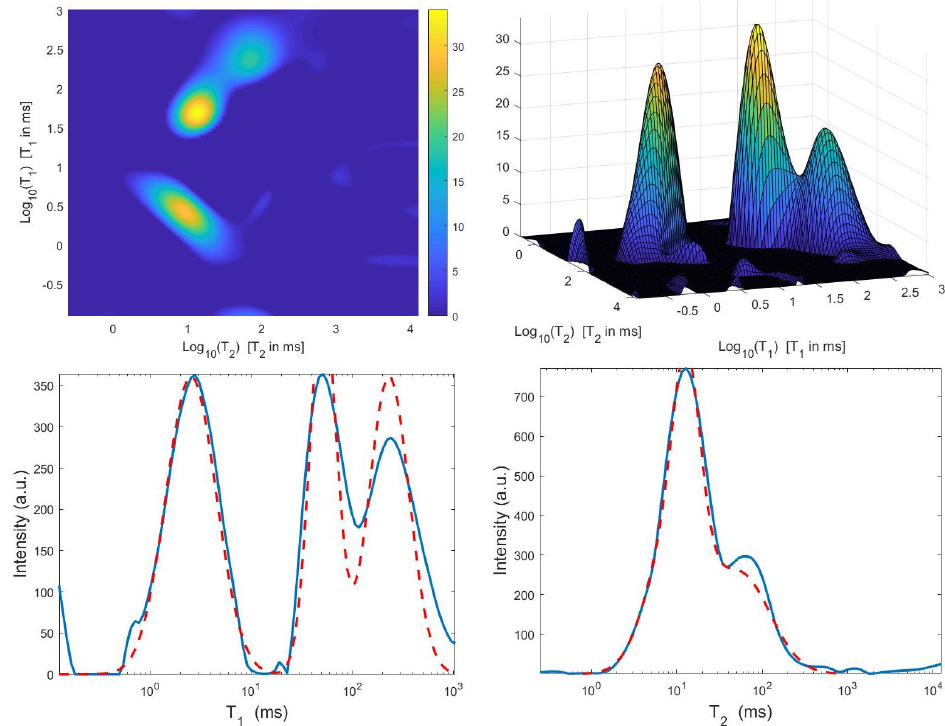
Figure 11. VSH method: restored T 1 – T 2 distribution and projections along the T1 and T2 dimensions ( τ =